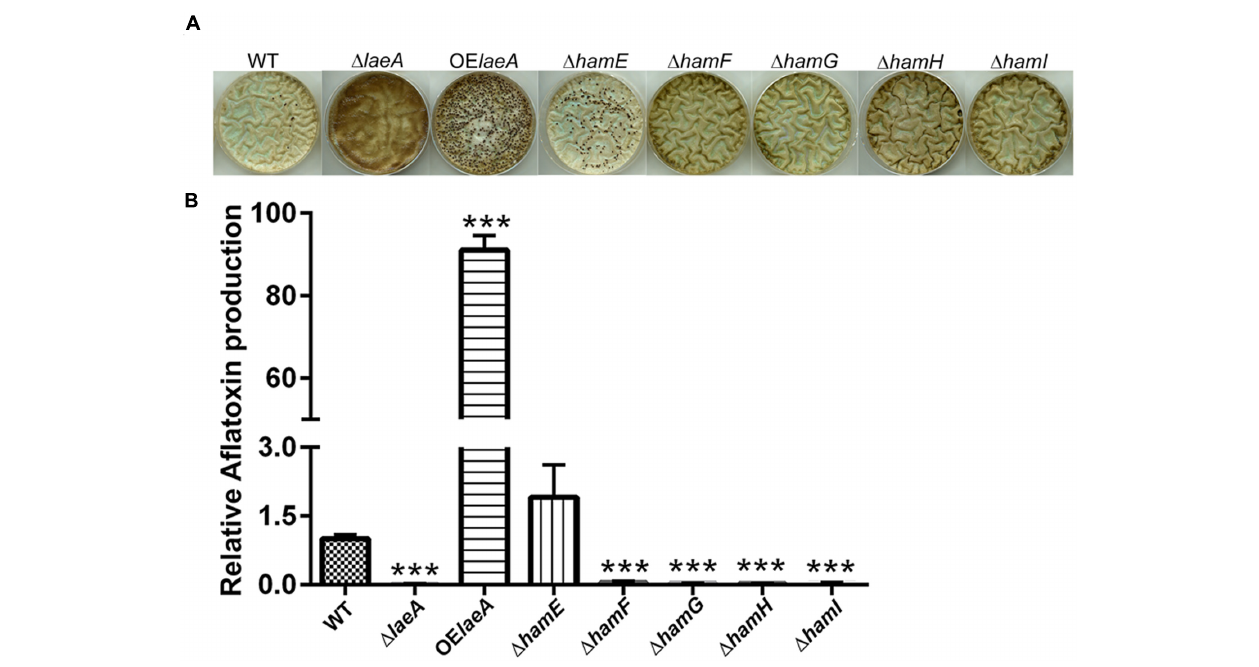
FIGURE 2 | Sclerotia formation (Panel A) and aflatoxin production (Panel B) of ham mutants in GMM+2% sorbitol medium. (A) Sclerotia. (B) Aflatoxin. ∗∗∗ P < 0.001. 10 6 spores/plate were cultured in GMM+2% sorbitol under dark for 5 days at 29 ◦ C, spores were washed away by 70% EtOH and pictures taken to observe sclerotial formation. 1.4 cm cores were excised from each plate and extracted for analysis of aflatoxin levels via HPLC. Average of three plates for each strain.